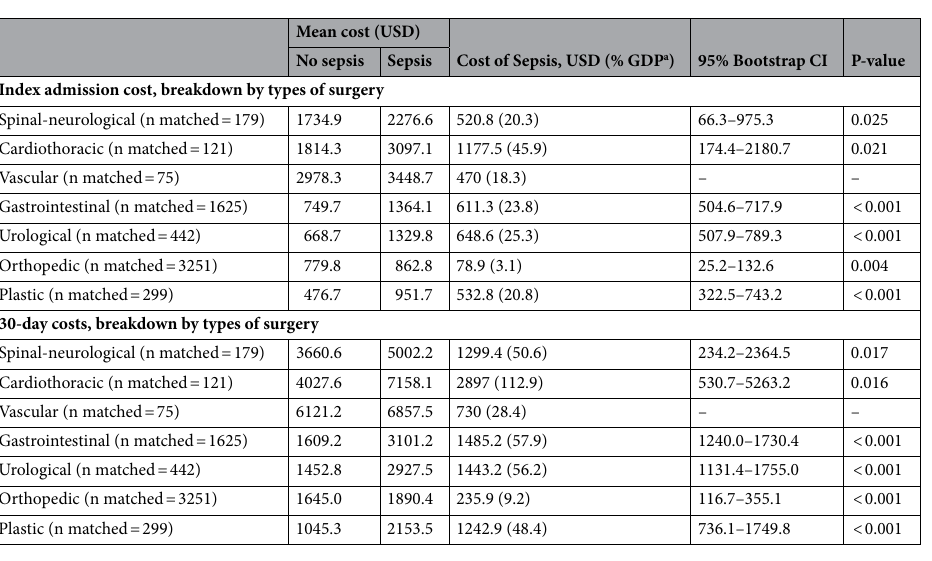
Table 3. Estimated incremental costs, by type of surgery and complications. 95% CI 95% Confidence interval; All estimates were calculated using a matched sample. § Compared to GDP per capita in Vietnam in 2018 (2,566